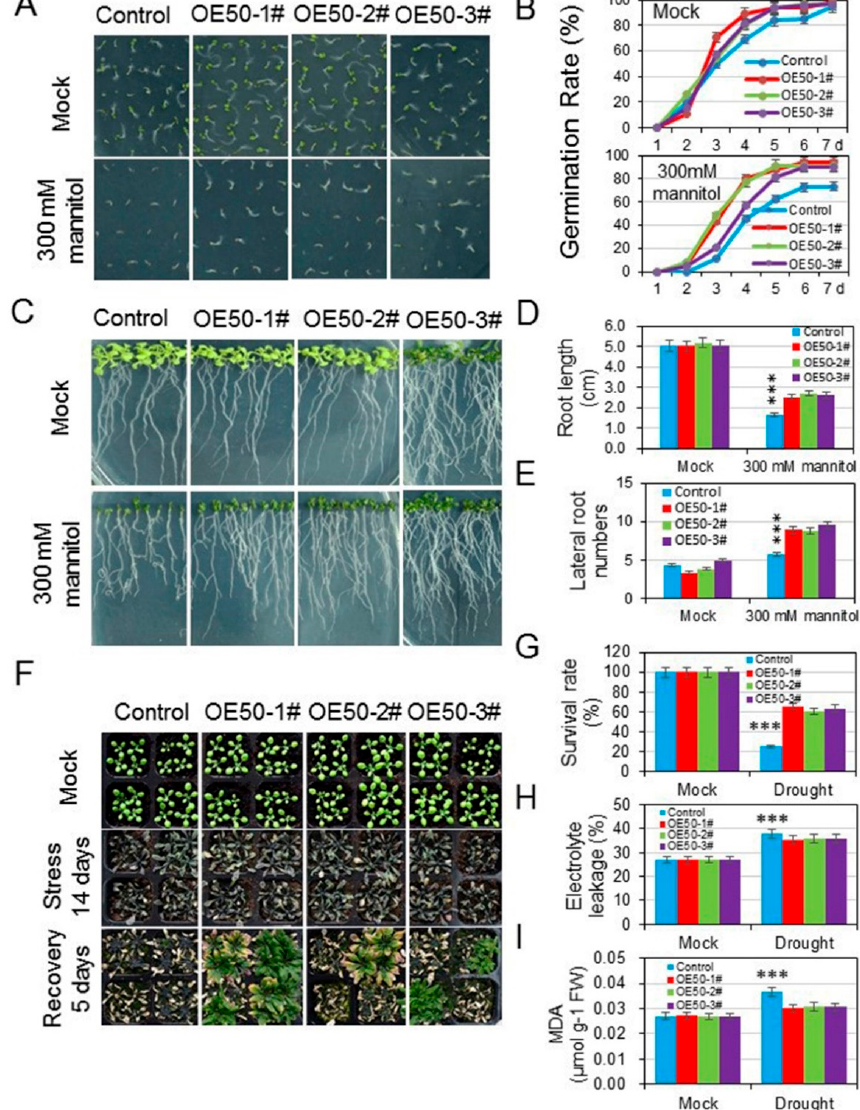
Figure 5. Overexpression of HcWRKY50 in Arabidopsis -enhanced drought tolerance. ( A , B ) The seed germination rates of HcWRKY50 transgenic and control lines was compared when grown on 300 mM mannitol. Photographs were taken 7 d after germination. ( C – E ) The root lengths and lateral root numbers of control and transgenic seedlings were photographed and measured after treatment with 300 mM mannitol. ( F – I ) Three-week-old control and transgenic Arabidopsis seedlings were grown without water for 2 weeks and were then re-watered for 5 days ( F ). Plant survival rate measurements were taken under drought treatment ( G ), and electrolyte leakage ( H ) and MDA contents ( I ) were measured after 14 d of drought stress. All values represent the means of three independent biological replicates; error bars indicate the SD. Significant differences are represented by *** p < 0.01, respectively, by ANOVA analysis. 3.6. HcWRKY50 Regulated ABA-Induced Stomatal Closure and Decreased the Stomatal Density Water loss rate is an essential factor for evaluating drought tolerance. In line with the increased drought tolerance of the HcWRKY50 overexpression lines, the leaves of these transgenic lines showed a lower water loss rate than the leaves of the control lines (Figure